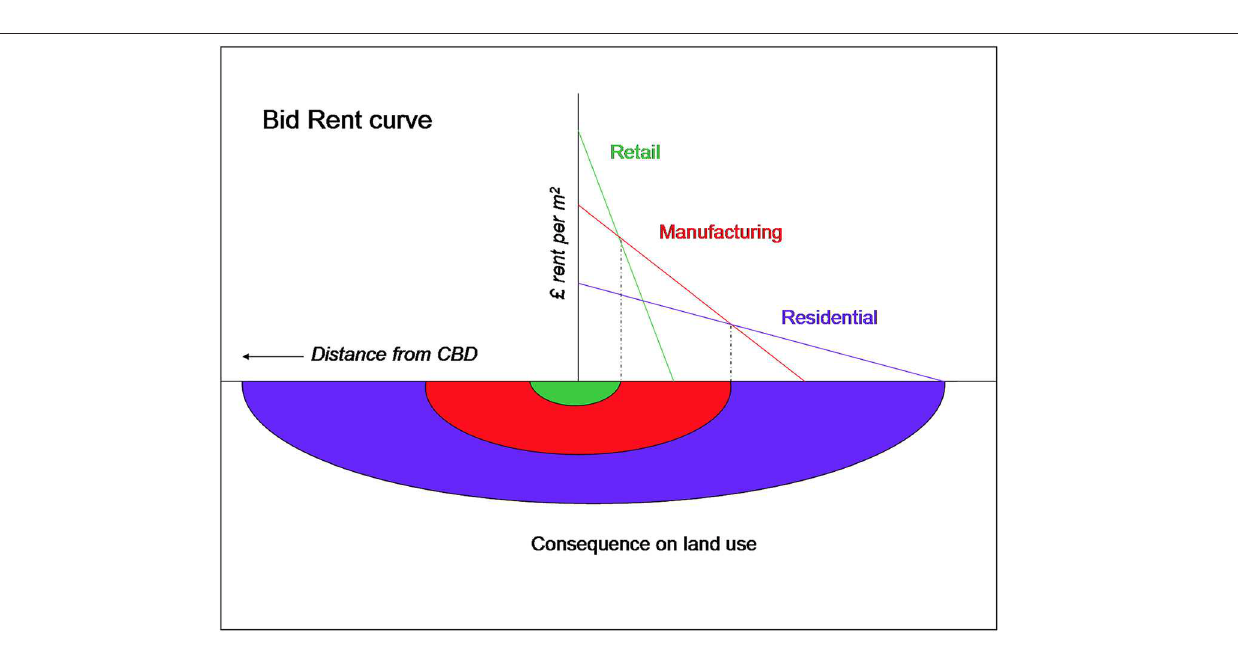
FIGURE 4 | Simplified version of bid rent curves based on general land values (i.e., distance from city center) without complicating factors. Image illustrates three types of land uses and their bidders’ willingness/ability to compete in certain zones over others. (SyntaxError55 at the English Wikipedia) [CC BY-SA 3.0 (http://